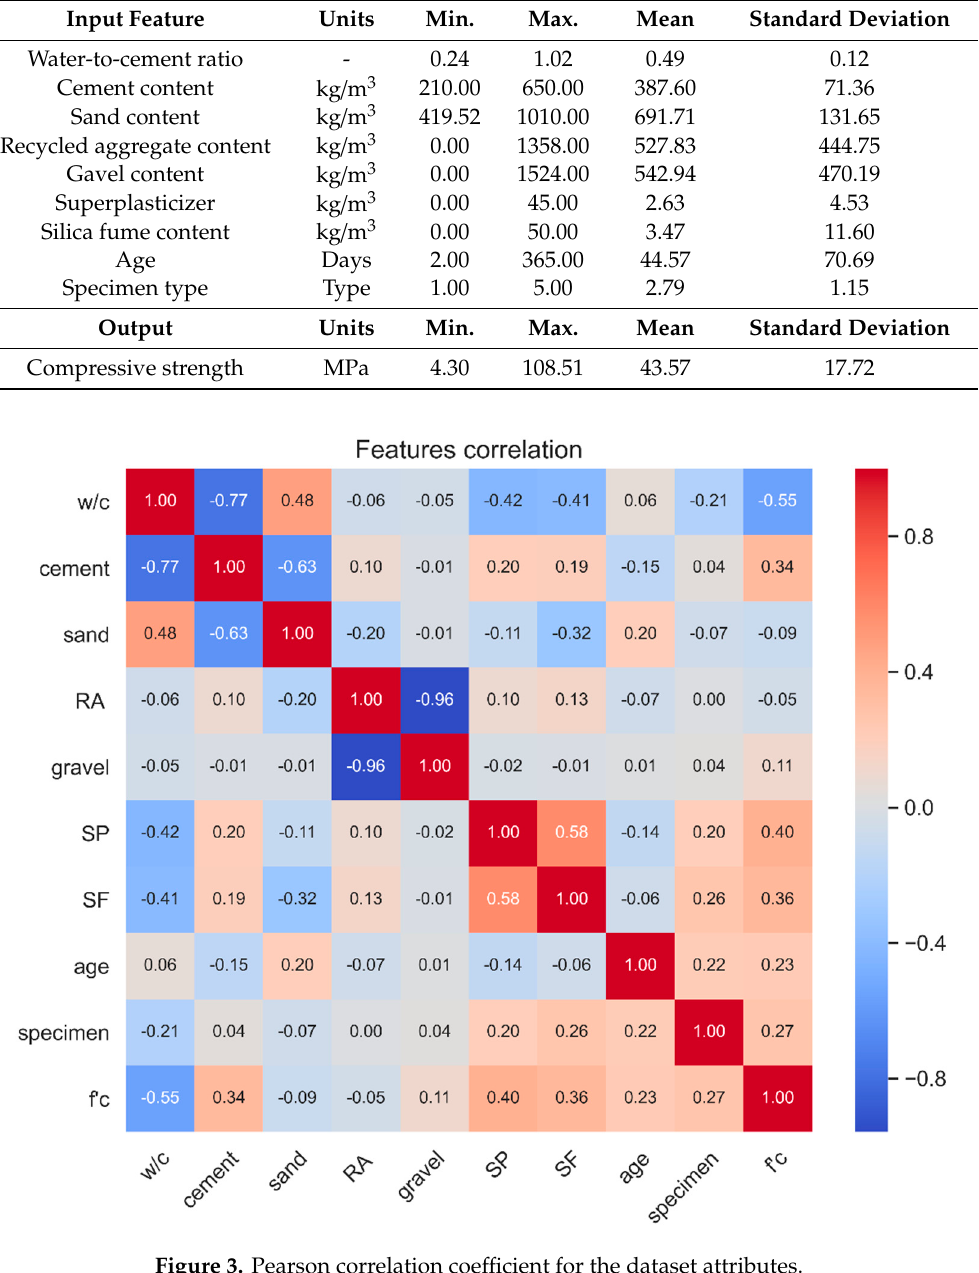
Figure 3. Pearson correlation coefficient for the dataset attributes.